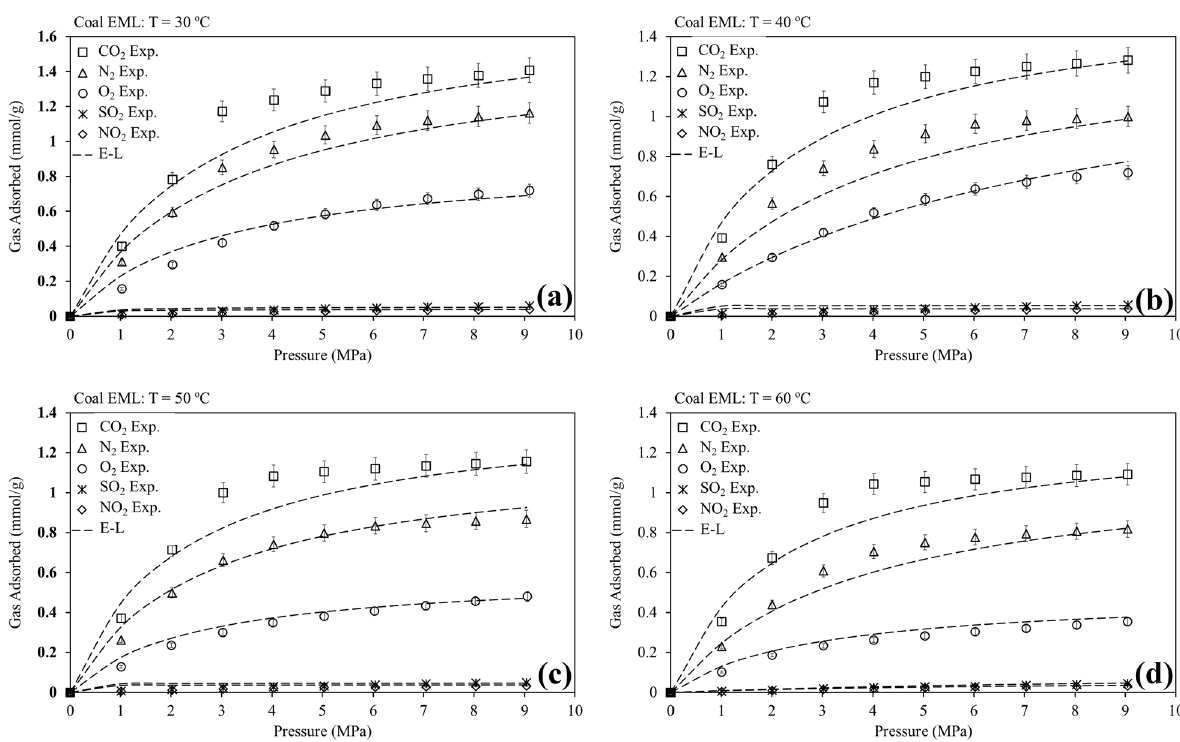
Fig. 8 Extended-Langmuir model fit for flue gas sorption on Coal EML at a 30 ºC, b 40 ºC, c 50 ºC, and d 60 ºC